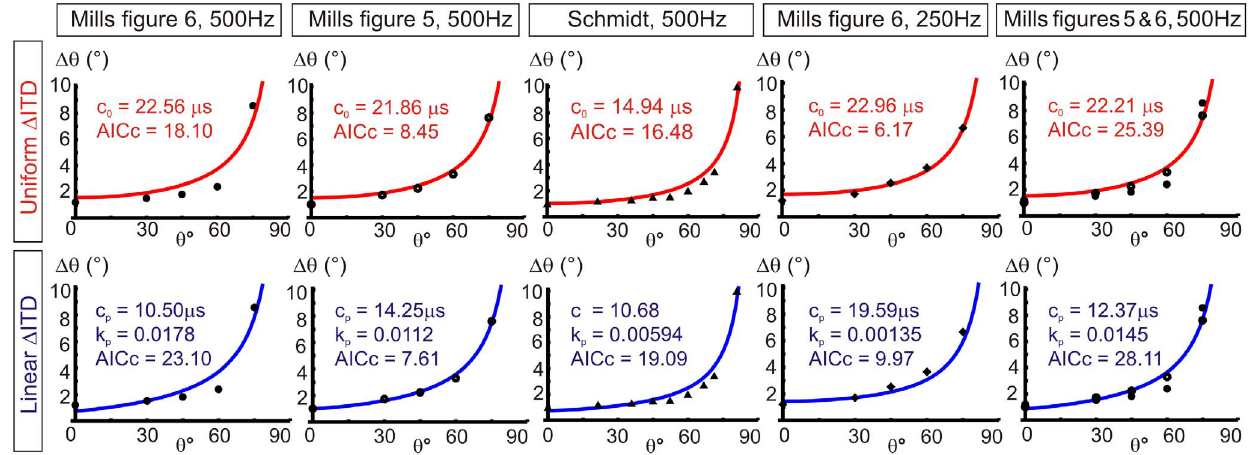
Figure 4. Best-fit acuity curves for uniform or linear D ITD distributions. Candidate uniform and linear D ITD models used to find best-fit acuity ( Dh ) distributions for five acuity data sets. Uniform distributions are described by parameter c 0 and linear distributions are described by parameters c p and k p . As with the best-fit descriptions of D ITD distributions, best-fit acuity distributions have low k p values for the linear D ITD case, close to the uniform case. AICc values indicate that the majority of acuity data sets are more appropriately described by uniform D ITD distribution as these have lower AICc values than for a linear D ITD distribution (comparing the same data sets).